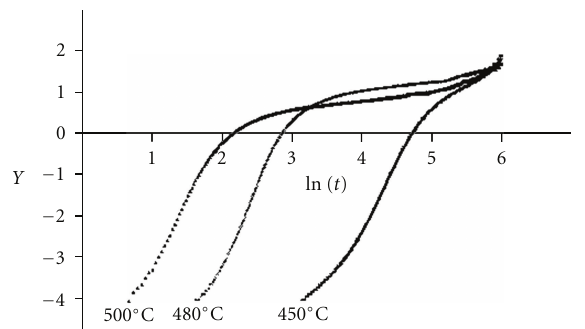
Figure 4: Test of Avrami’s model validity: the representation of t ) ( t in mn) shows that Y = ln[ − ln( Δ m − Δ m ) / Δ m 0 0 ] versus ln( two main types of behaviors can be observed as time increases.